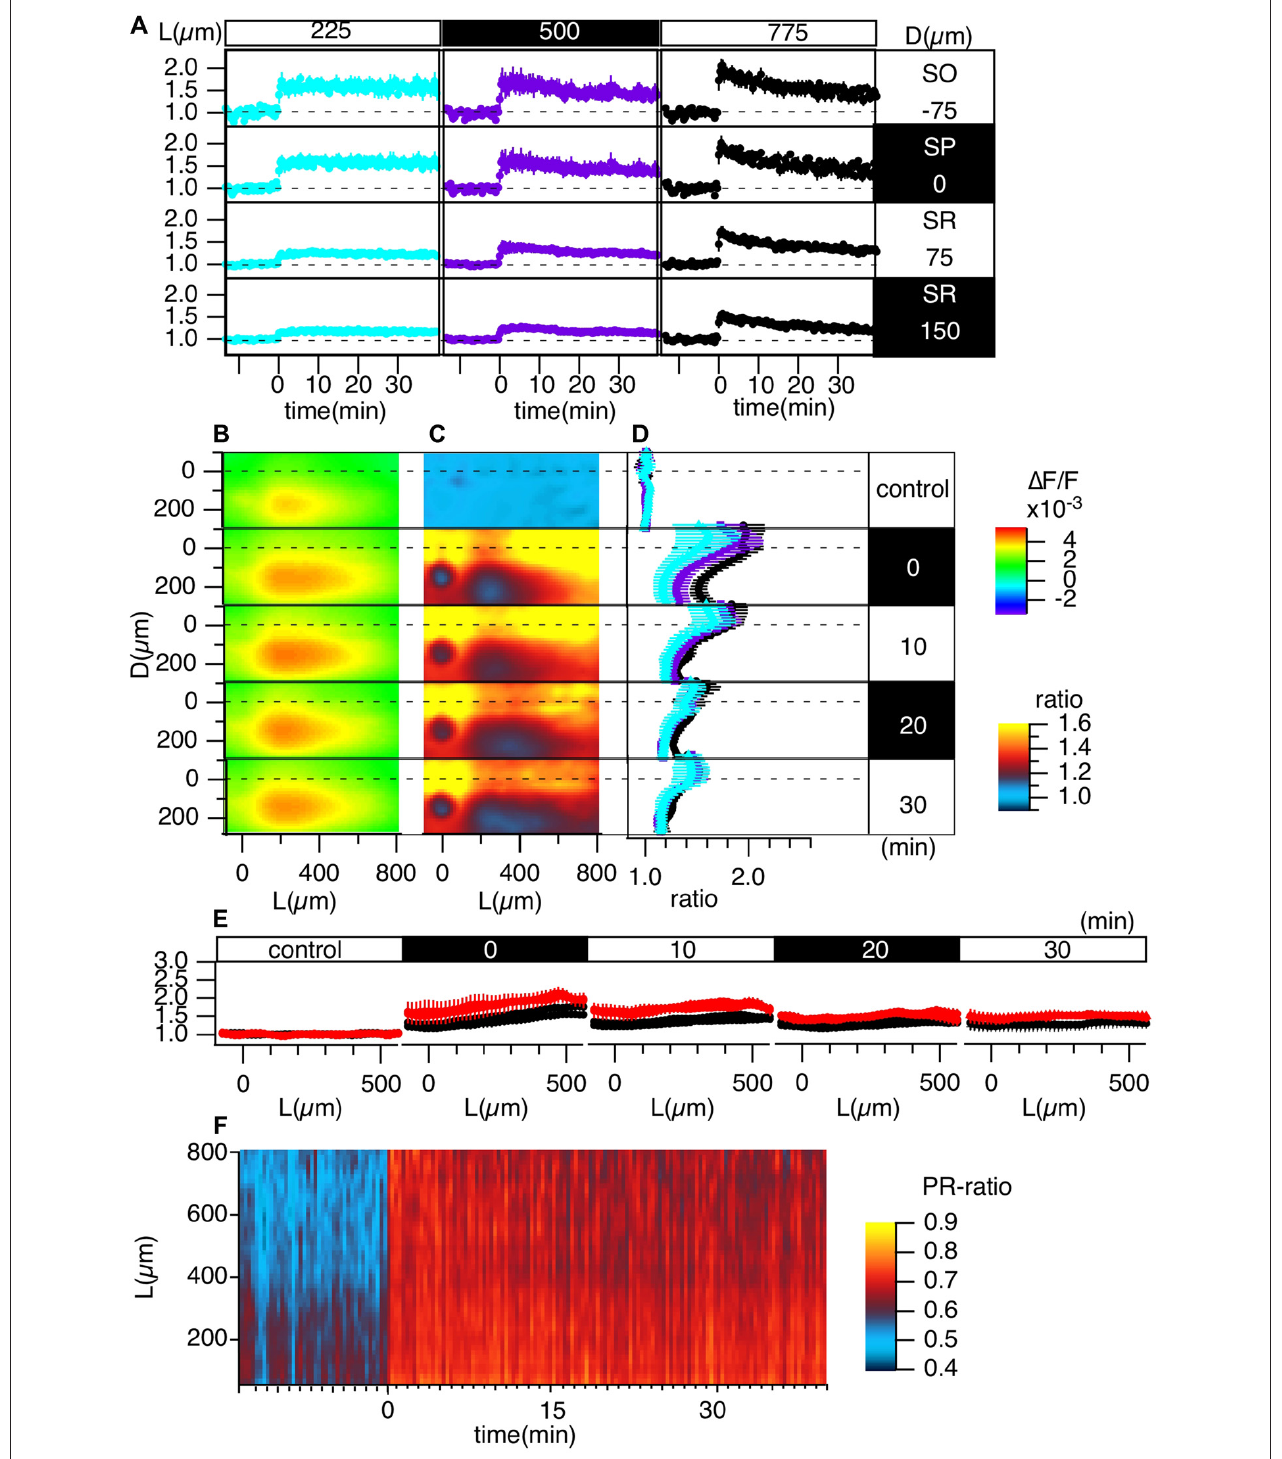
FIGURE 4 | Grouped evaluation of TBS-induced LTP. (A) The time changes in the normalized peak amplitude of the optical signals at representative points for three different L positions [ L = 225 (cyan), 500 (purple), 775 (black) µ m] and four different D positions ( D = − 75, 0, 75, 150 µ m). (B) The peak values mapped in the D-L coordinates. (C) The LTP ratio in the D-L coordinates. (D) The line profiles of C at different L positions [225 (cyan), 500 (purple), 775 (black) µ m] at each time point. (E) The line profile along the L axis at different time points corresponding to the control recording and recordings made at 0, 10, 20 and 30 min from TBS. (F) The time change in the ratio of the line profiles at the SO ( D = − 75) vs. the SR ( D = 150), i.e., the PRR, along the L axis. N = 4, n = 12, bars in (A,D,E) indicate SEM.